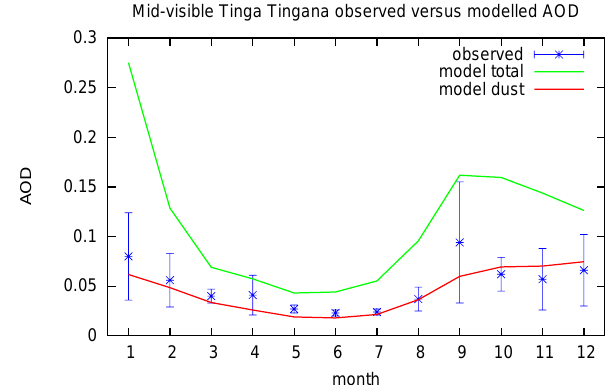
Fig. 3. Annual cycle of mid-visible aerosol optical depth at Tinga Tingana (approx. 140 ◦ E, 29 ◦ S). Sun photometer-based observed monthly means are shown in blue, with error bars denoting the stan- dard deviation of individual observations. Modelled optical depths due to dust (red curve) and all tropospheric aerosols (green curve) are taken from the DUST